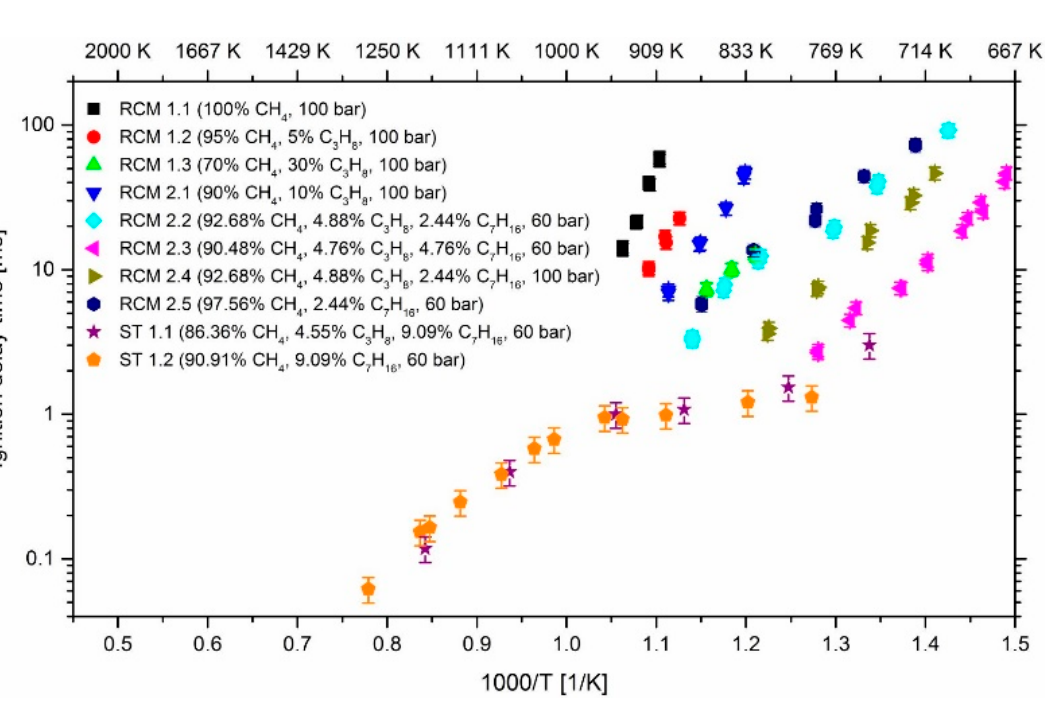
Figure 3. Measured IDTs from the RCM and ST (this study and [37]).